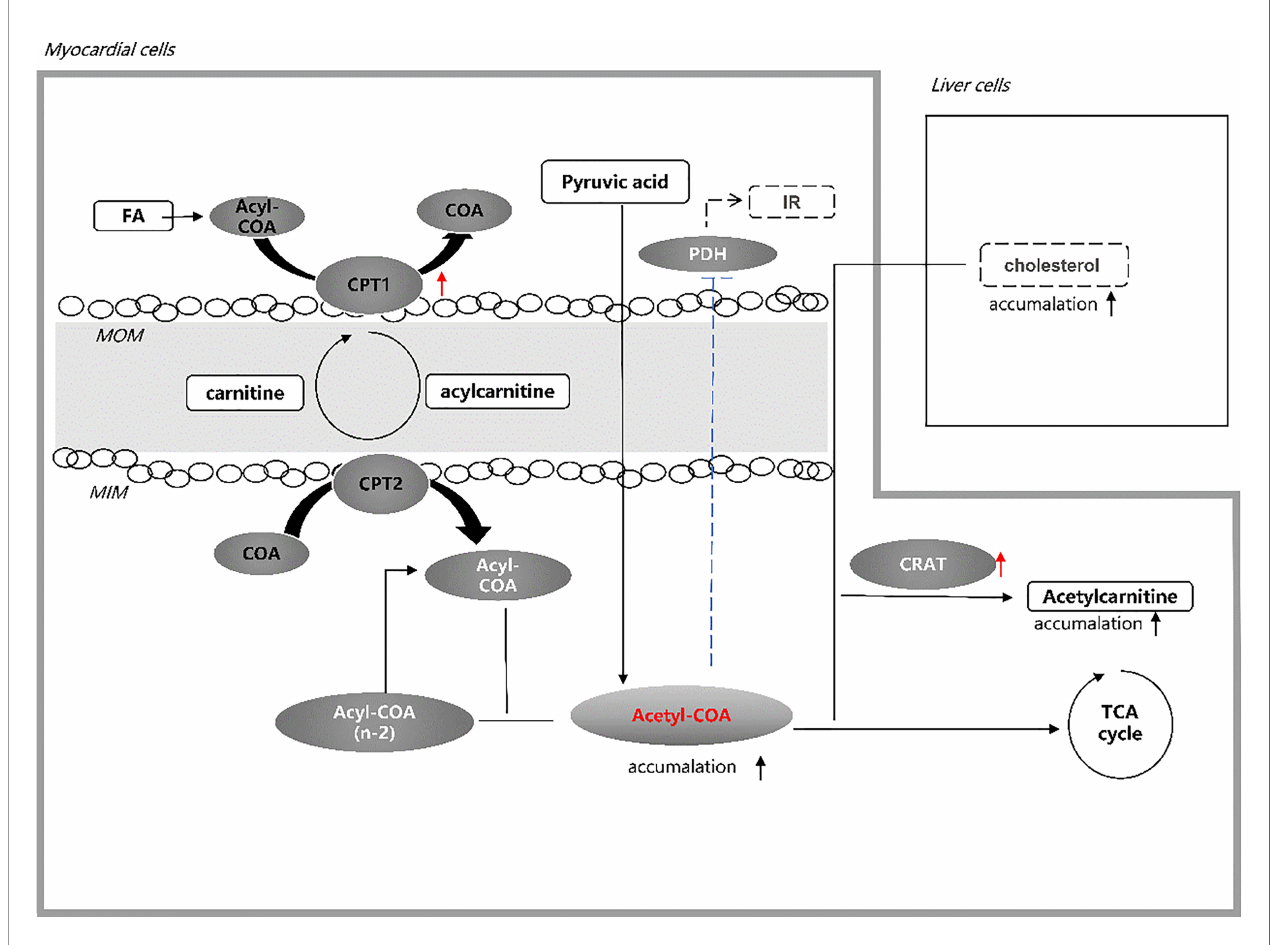
FIGURE 2 | Hypothesis of acetylcarnitine association with CVD in T2DM. Elevated acetylcarnitine due to the higher activity of CPT1 and CRAT in patients with CVD in T2DM may re fl ect the state of accumulation of acetyl-CoA exceeding the capacity of the TCA cycle. Increased level of acetyl-CoA in the heart of T2DM patients leads to intensi fi ed insulin resistance by inhibiting PDH and increased cholesterol production in liver cells. Both pathways may account for the high CVD risk in T2DM. FA , fatty acid; CoA , co-enzyme A; CPT 1 , carnitine palmitoyl transferase 1; MOM , mitochondrial outer membrane; MIN , mitochondrial inner membrane; CPT 2 , carnitine palmitoyl transferase 2; IR , insulin resistance; PDH , pyruvate dehydrogenase; CRAT , carnitine acetyltransferase; TCA , tricarboxylic